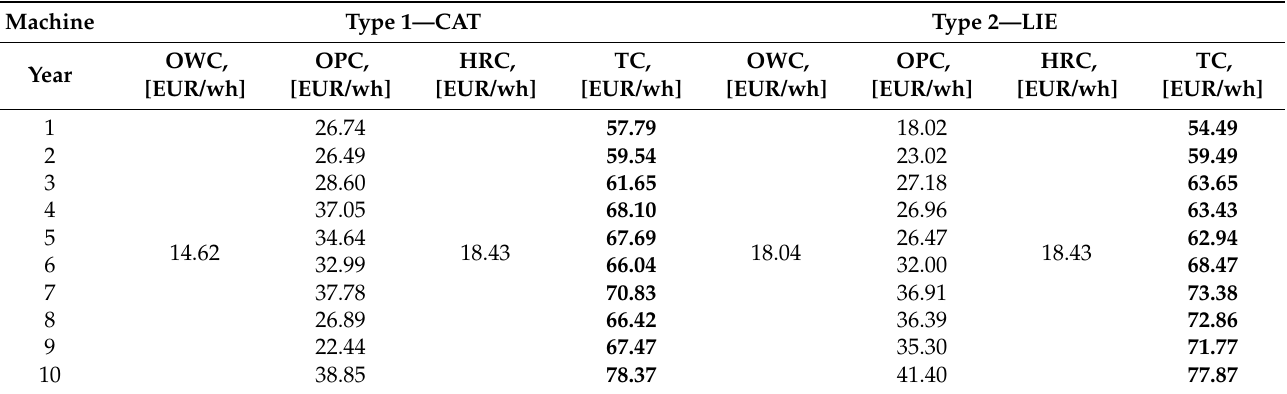
Table 2. Specific costs of analyzed